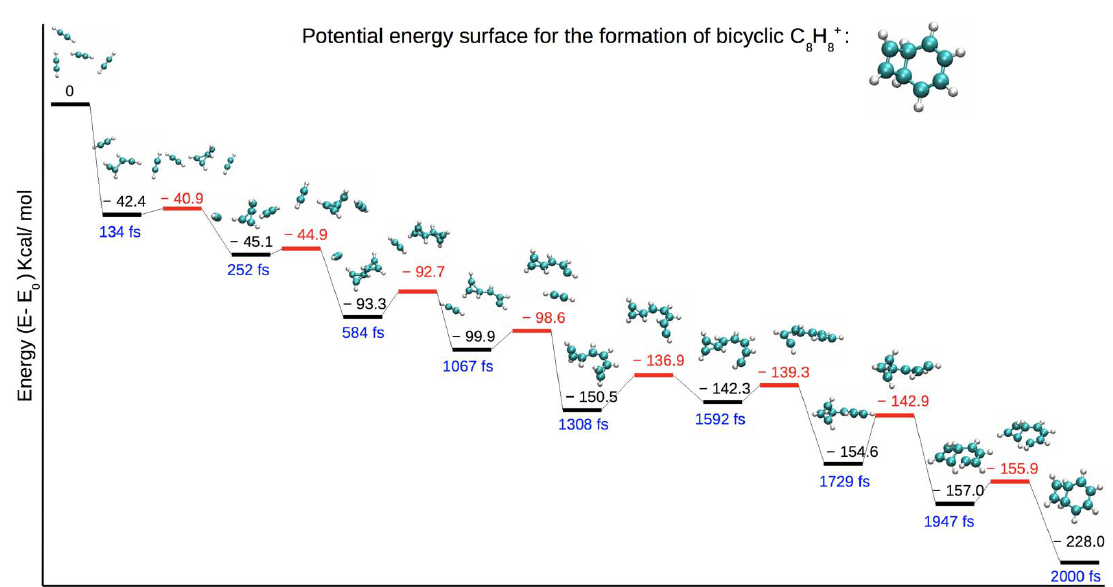
8+ core structures. ( a – f ): isomers on the C 8 H